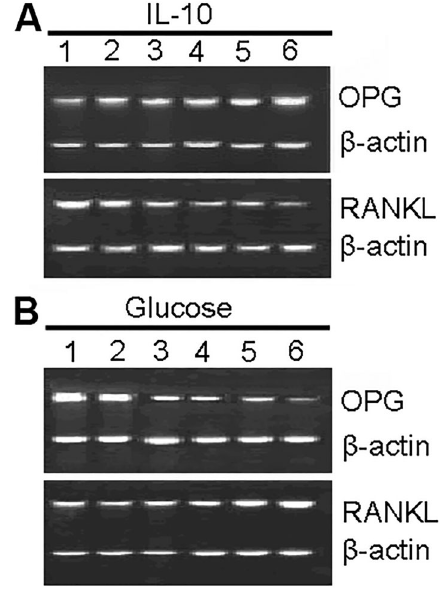
Figure 2. Effects of IL-10 ( A ) and glucose ( B ) at different concentrations on the mRNA expression of osteoprotegerin (OPG) and receptor activator of nuclear factor- k B ligand (RANKL) in human periodontal ligament fi broblasts. Panel A , lanes 1 – 6 : cells treated with interleukin-10 (IL-10) at 0, 1, 10, 25, 50, and 100 ng/mL, respectively. Panel B , lanes 1 – 6 : cells treated with glucose at 0, 5.5, 10, 20, 30, and 40 mmol/L, respectively.